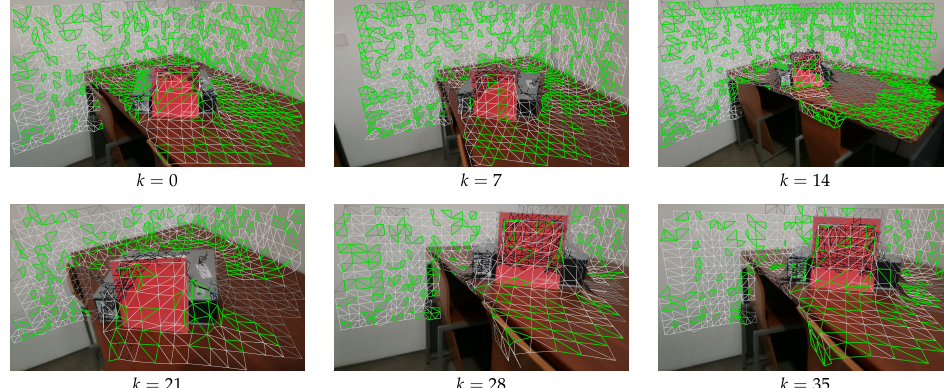
Figure 10. Random criteria for selecting the faces; Color notation: black, occluded faces; gray, depth inconsistent faces; white, available faces; green, selected